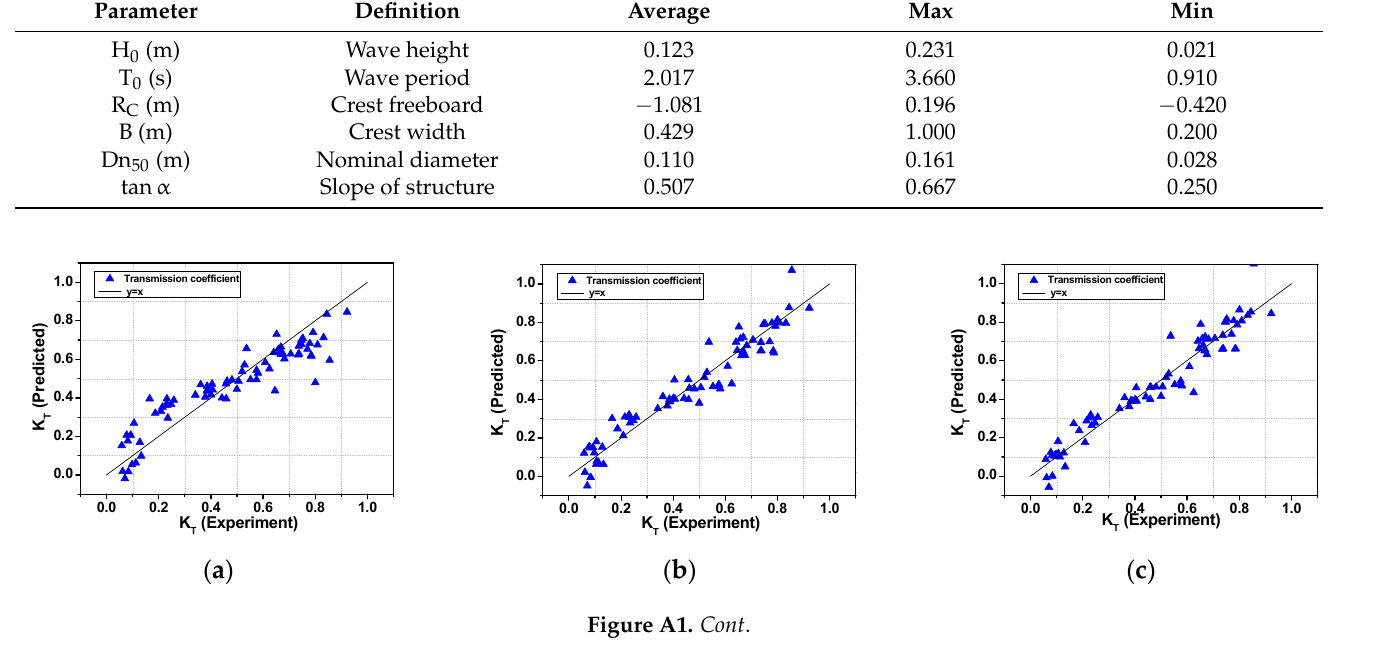
Table A1. The indication of the range of the parameters.